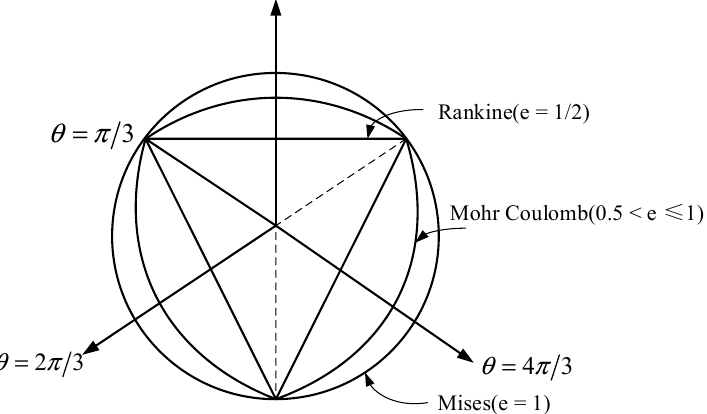
Figure 2. Trajectories of different constitutive models on the π plane.